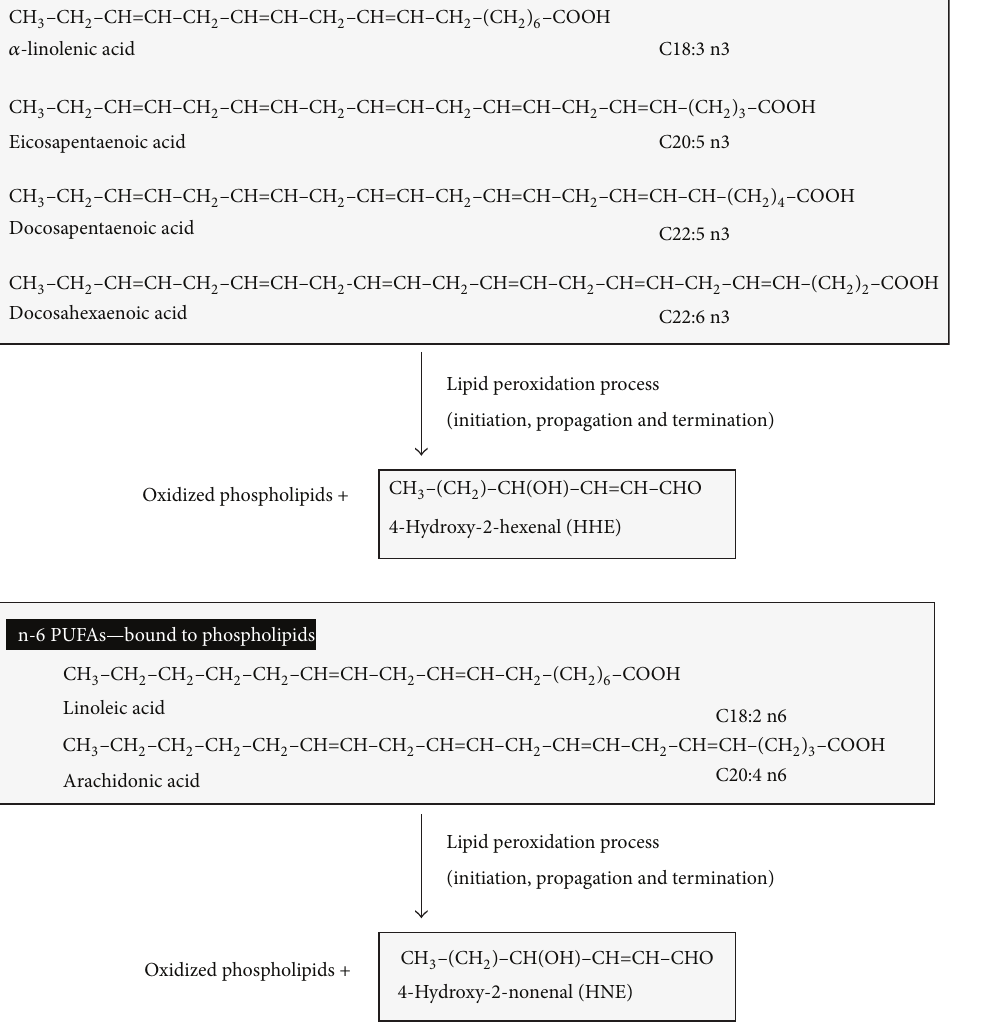
to follow the time course of membrane lipid peroxidation, we measured simultaneously physical and biochemical